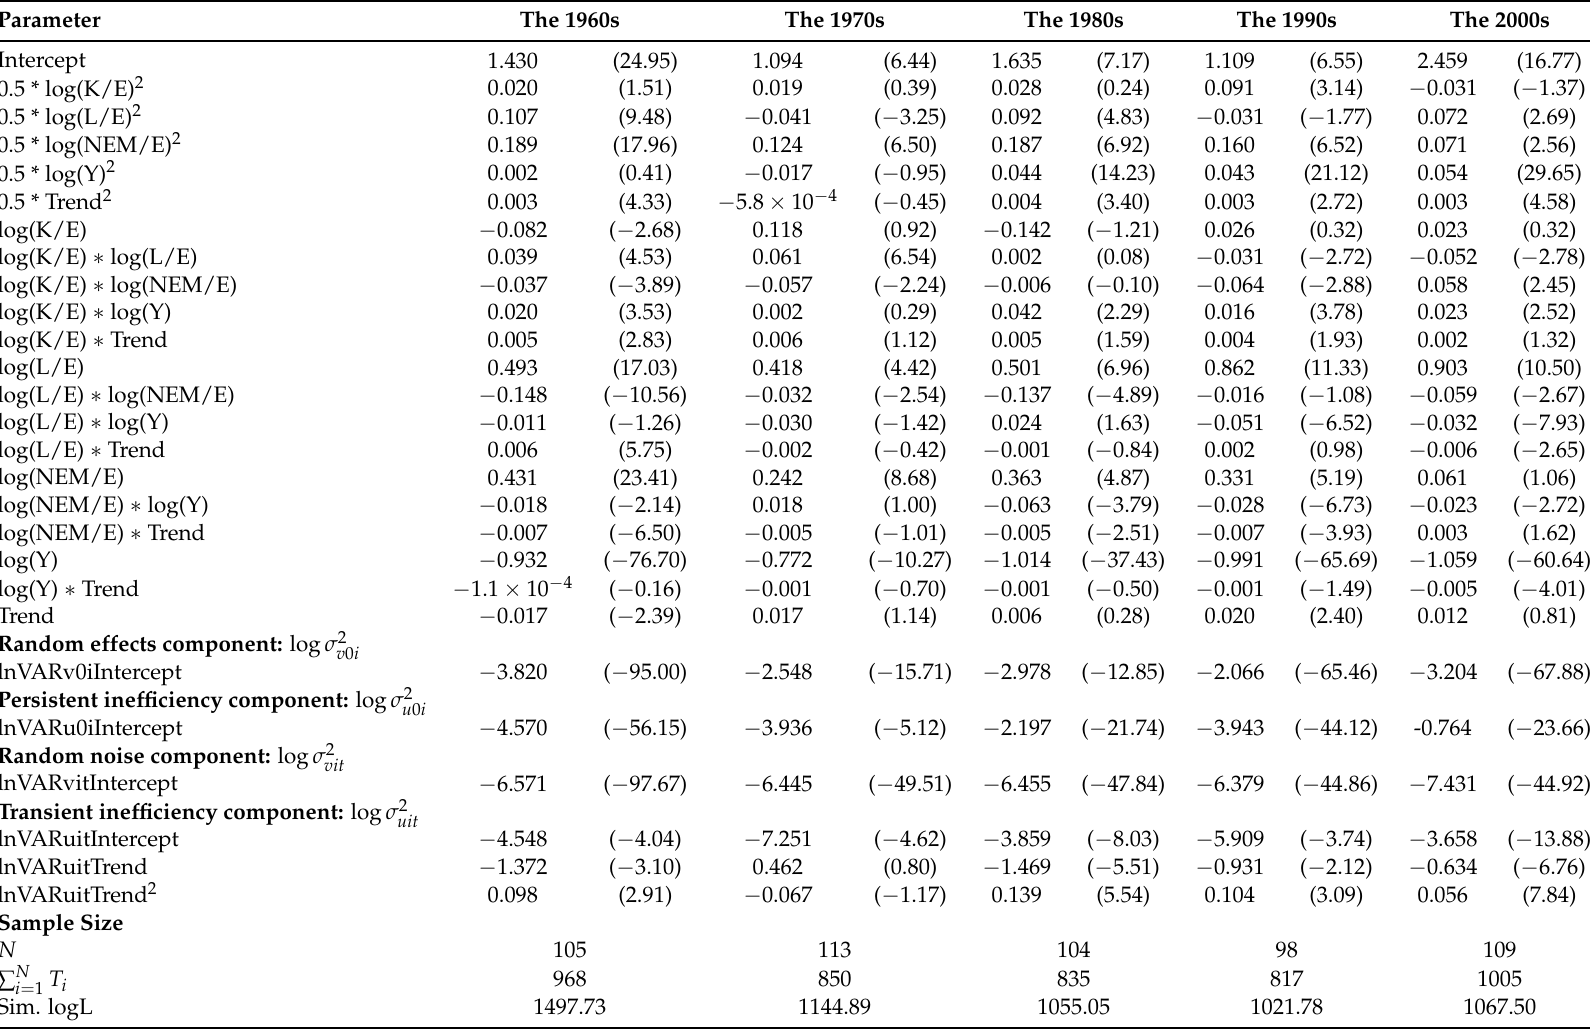
Table 2. Model 1 as in Equation (3). Dependent variable is − log E . z -values in